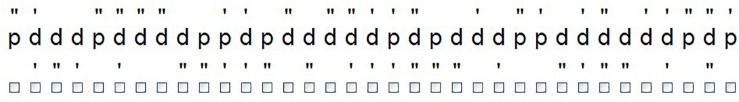
Example of a screen of the d2 test, comprising 35 letters that include 15 targets. Targets had to be marked by clicking the corresponding box.